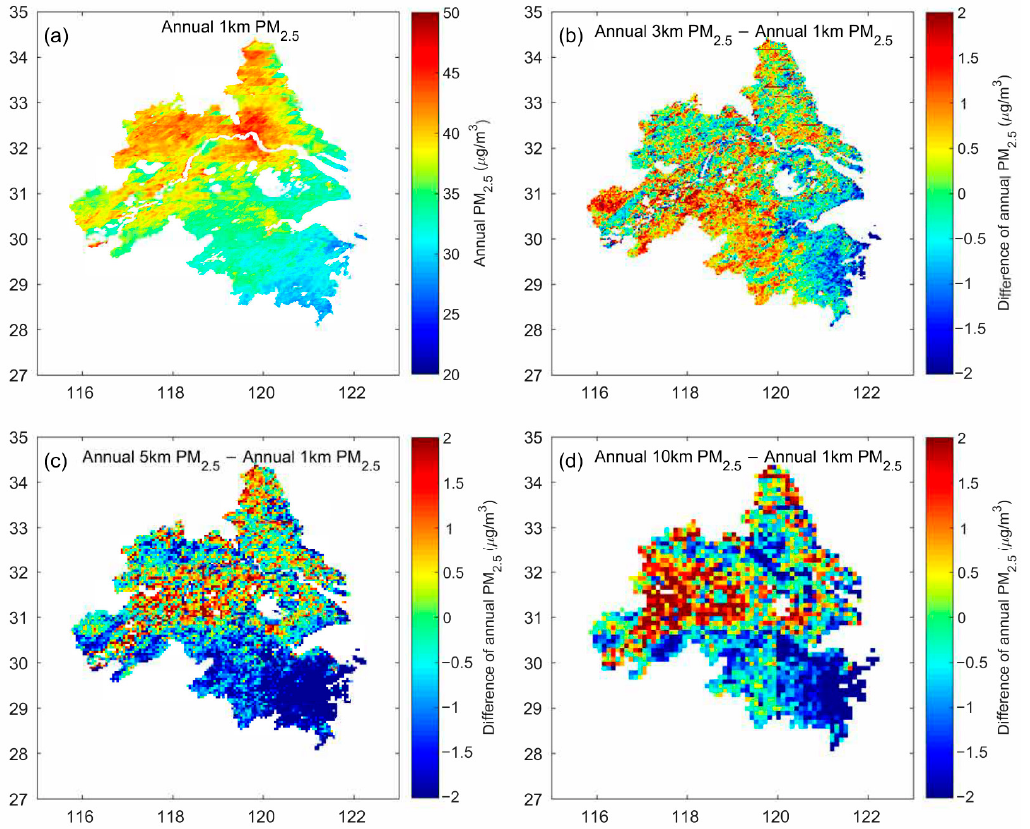
Figure 9. ( a ) Spatial distribution of annual PM 2.5 at 1 km and ( b – d ) its difference from coarser resolutions. PM 2.5 retrievals in this figure are based on the Random Forest (RF) model. Annual PM 2.5 estimations at 1 km are first aggregated to arithmetic mean values at a coarse resolution. Then, these aggregated values are compared to that from the PM 2.5 retrieval model at the coarse resolution.